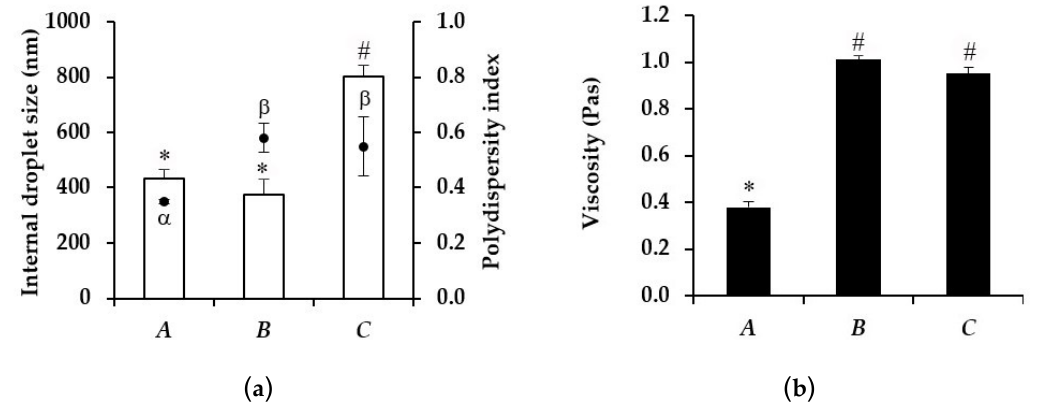
Figure 8 . Internal droplet size and polydispersity index ( a ) and viscosity ( b ) of microemulsion A , B , and C ( different letters (* and # ) denote significant statistically different internal droplet size and viscosity between groups; p < 0 . 05, whereas, different symbols ( α and β ) denote significant statistically different polydispersity index; p < 0 . 05 ).